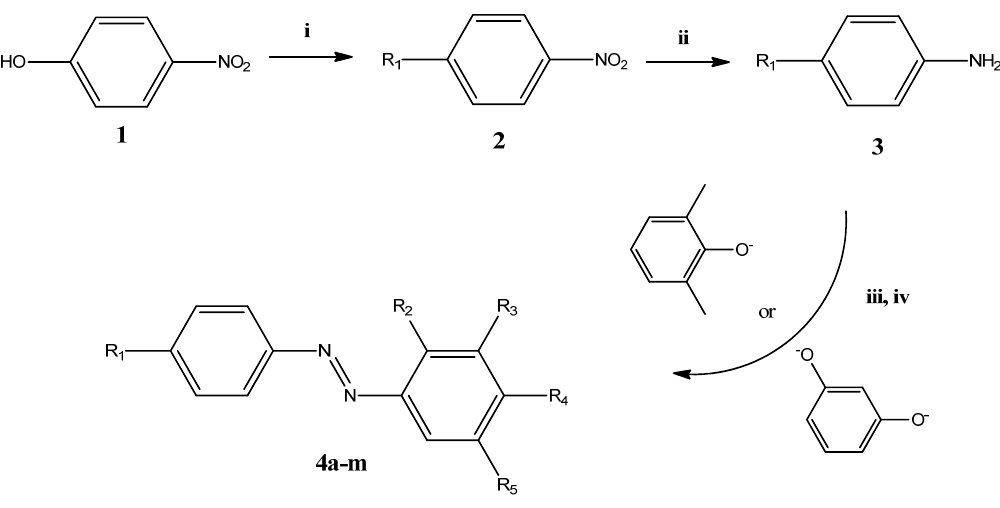
Figure 3. Synthetic route for compounds 4a – m . i : Alkylhalide, K 2 CO 3 , DMF reflux, 3 h; ii : SnCl 2 ,